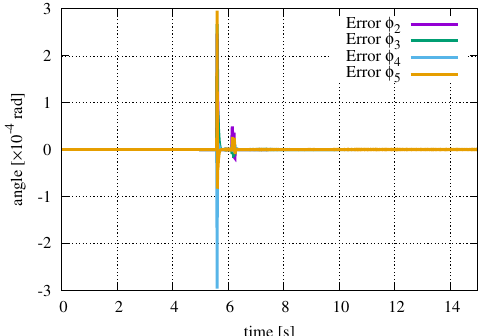
Figure 10. Case 1: Time variation of estimation error of the relative angles.